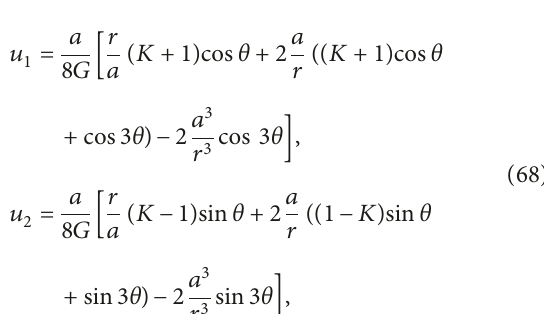
Figure 7: Strain energy convergence.